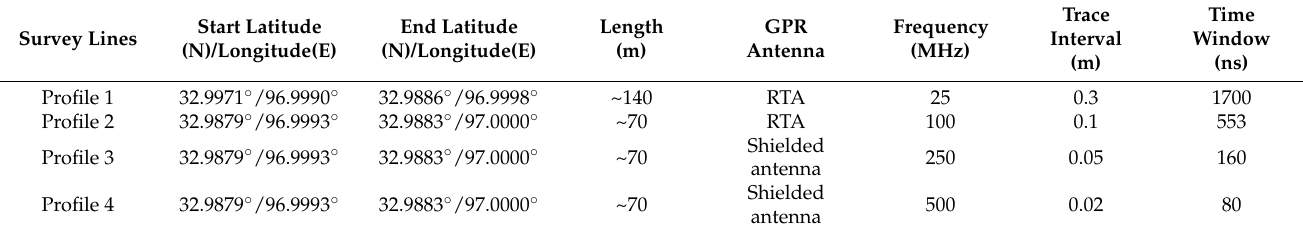
Table 1. Locations of GPR profiles and parameter settings of different frequencies GPR antennas.